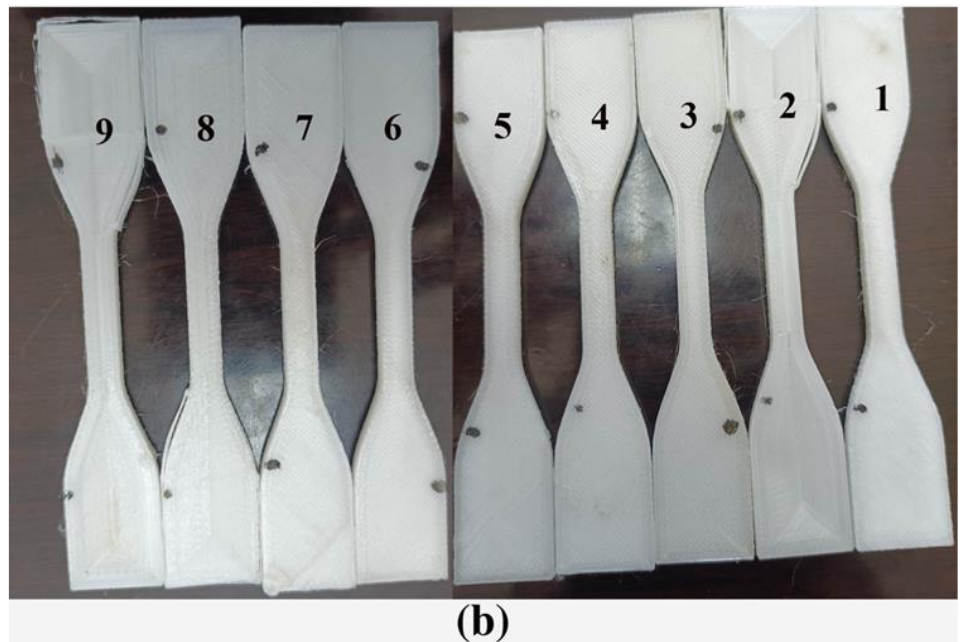
Figure 3. ( a ) FFF-Fabricated L18 experimental samples for ABS polymer. ( b ) FFF-Fabricated L9 experimental samples for PA-6 polymer.